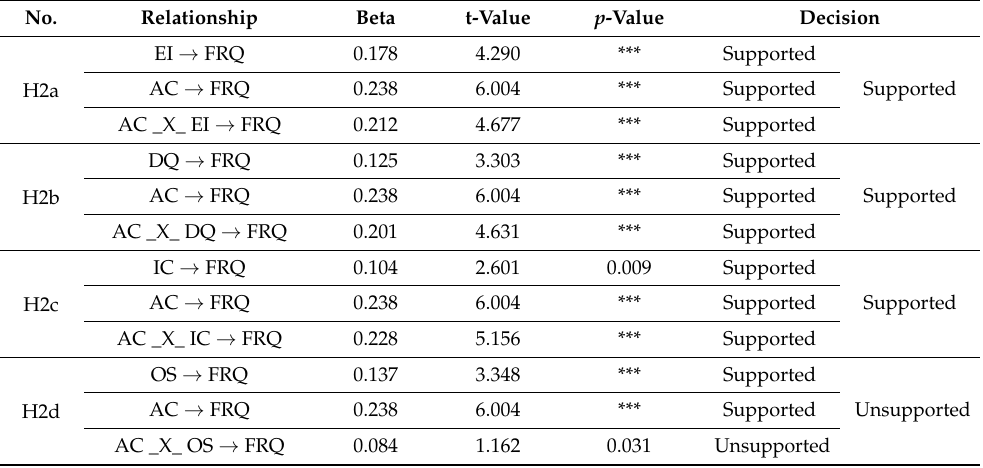
Figure 4. Statistical model of moderating factor of the audit committee. Table 6. Moderating effect of the audit committee on creative accounting and financial reporting